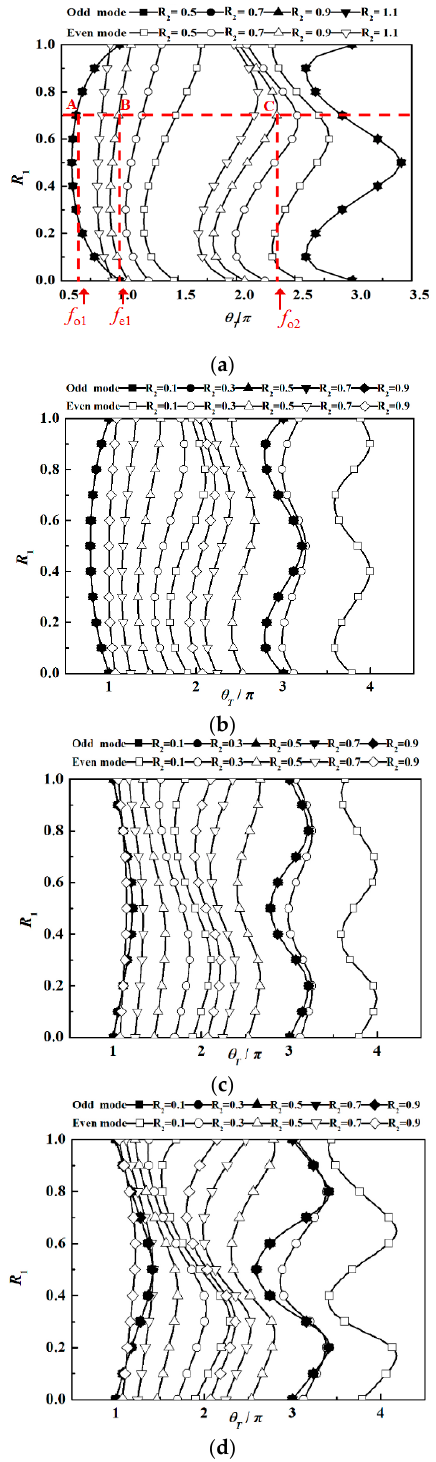
Figure 2. Length ratio R 1 with resonant electric length θ T using the MATLAB tool at various length ratios, R 2 = 0.1, 0.3, 0.5, 0.7 and 0.9 based on ( a ) K 1 = 0.25 and K 2 = 1, ( b ) K 1 = 0.5 and K 2 = 1, ( c ) K 1 = 2 and K 2 = 1 and ( d ) K 1 = 4 and K 2 =